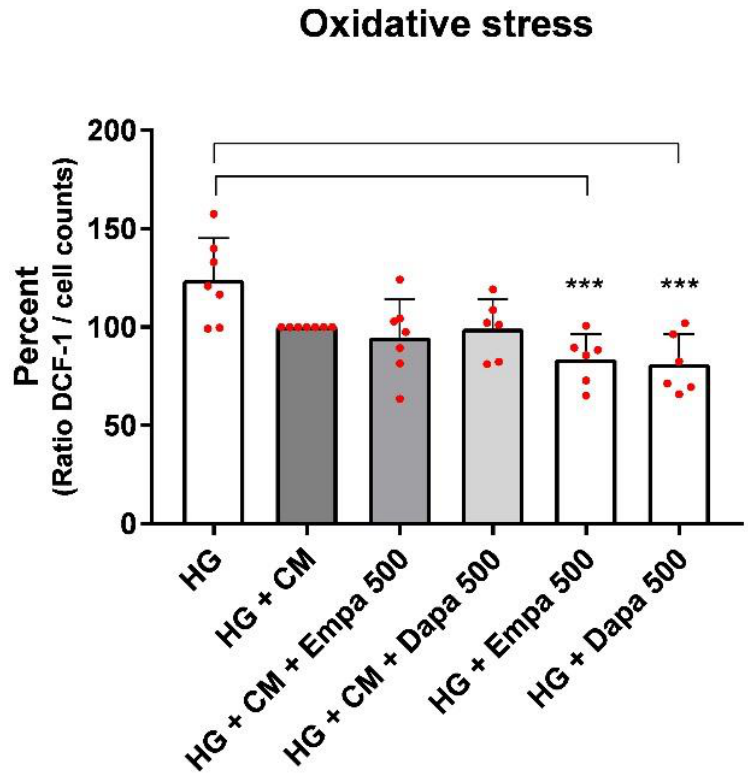
Figure 2. Formation of oxidative stress under diabetic and inflammatory culture conditions (DCF assay). The PTCs cultured in 96-well plates were incubated for 48 h in media containing empa- or dapagliflozin (500 nm) under a diabetic (high glucose) or diabetic in combination with an inflam- matory (cytokine mix, CM) environment. Then, 2 ’ ,7 ’ -dichlorodihydrofluorescein diacetate (20 µM in Hank`s buffered saline solution) was added for 30 min at 37 °C. Fluorescence of intracellular DCF was measured using a fluorescence reader with excitation and emission wavelengths of 485 and 538 nm, normalized to the cell counts, and the ratio was calculated as a percent (scatter plots with bar, mean ± SD, n = 6–7, *** p < 0.001 vs. HG).